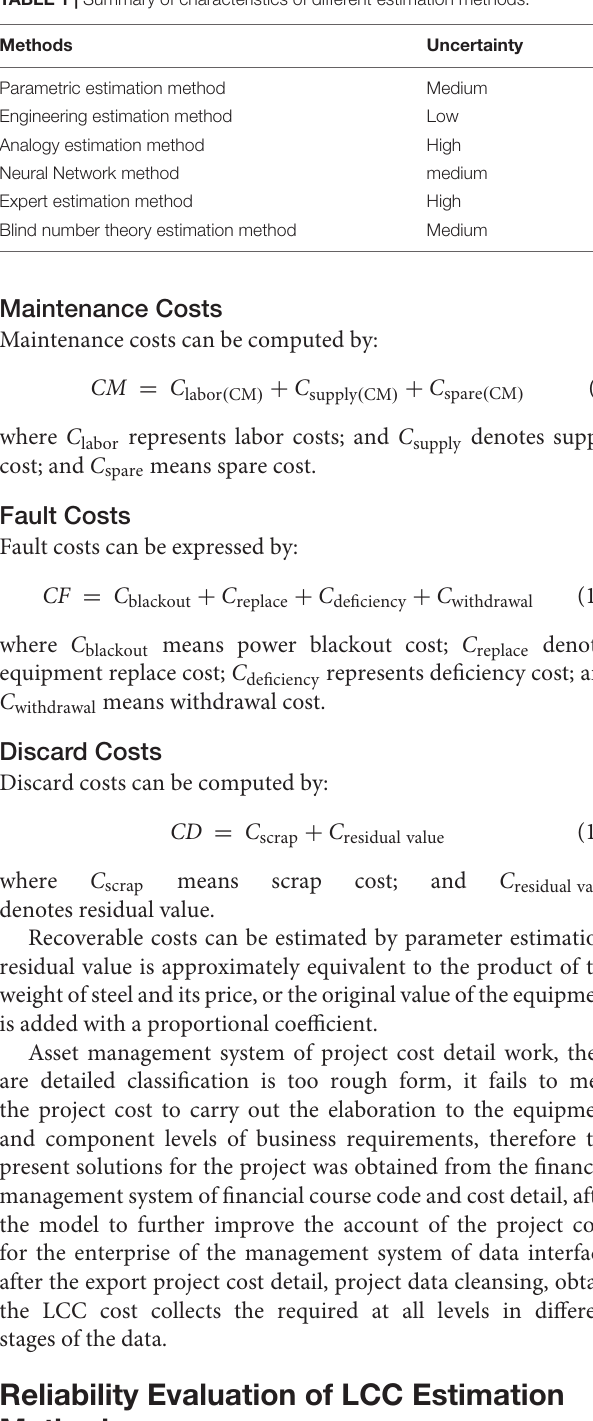
TABLE 1 | Summary of characteristics of different estimation